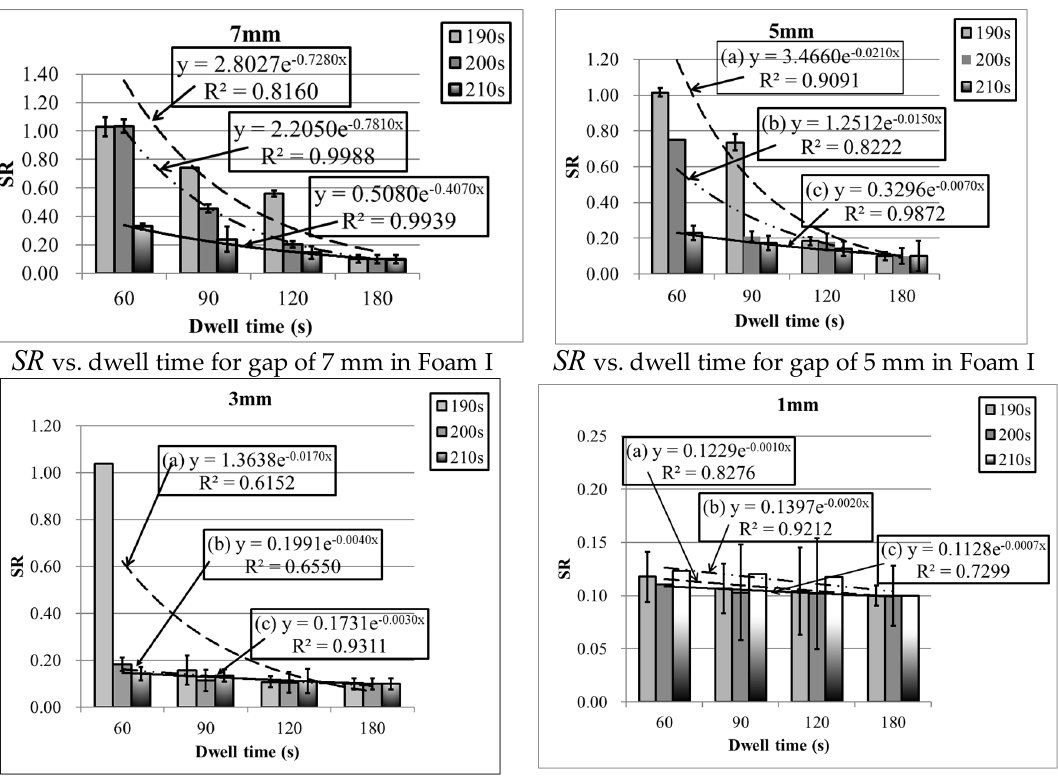
Figure 3. Regression curves of dwell time vs. moulding temperature with different gaps.